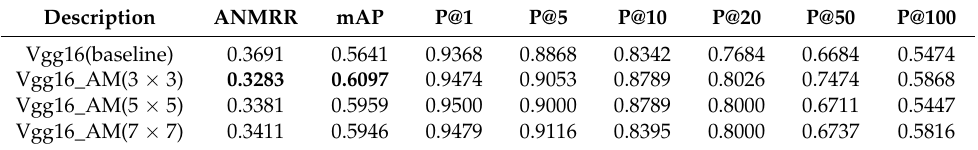
Table 2. Comparisons among different filter sizes. The best result is reported in bold.